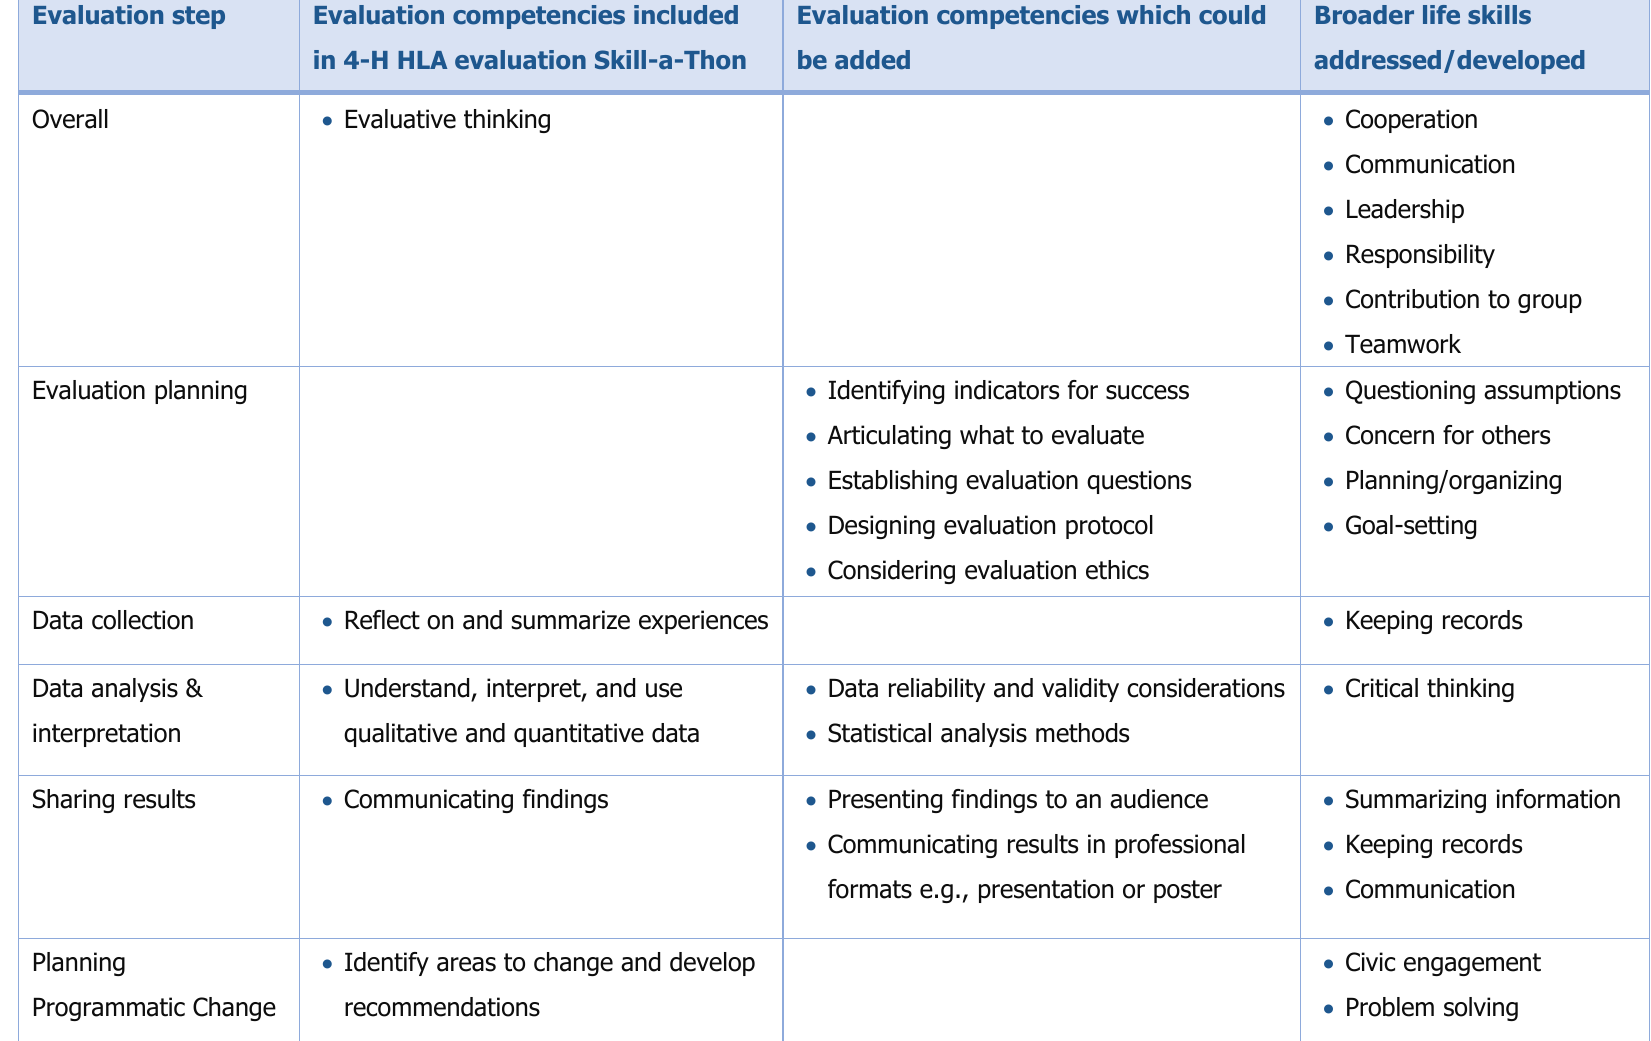
Table 2. Evaluation Competencies and Life Skills Targeted for Positive Youth